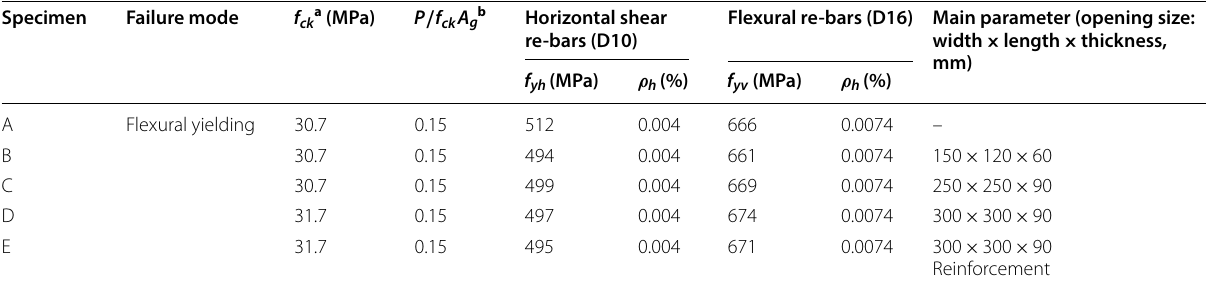
Table 2 Material properties and main parameters of test specimens.